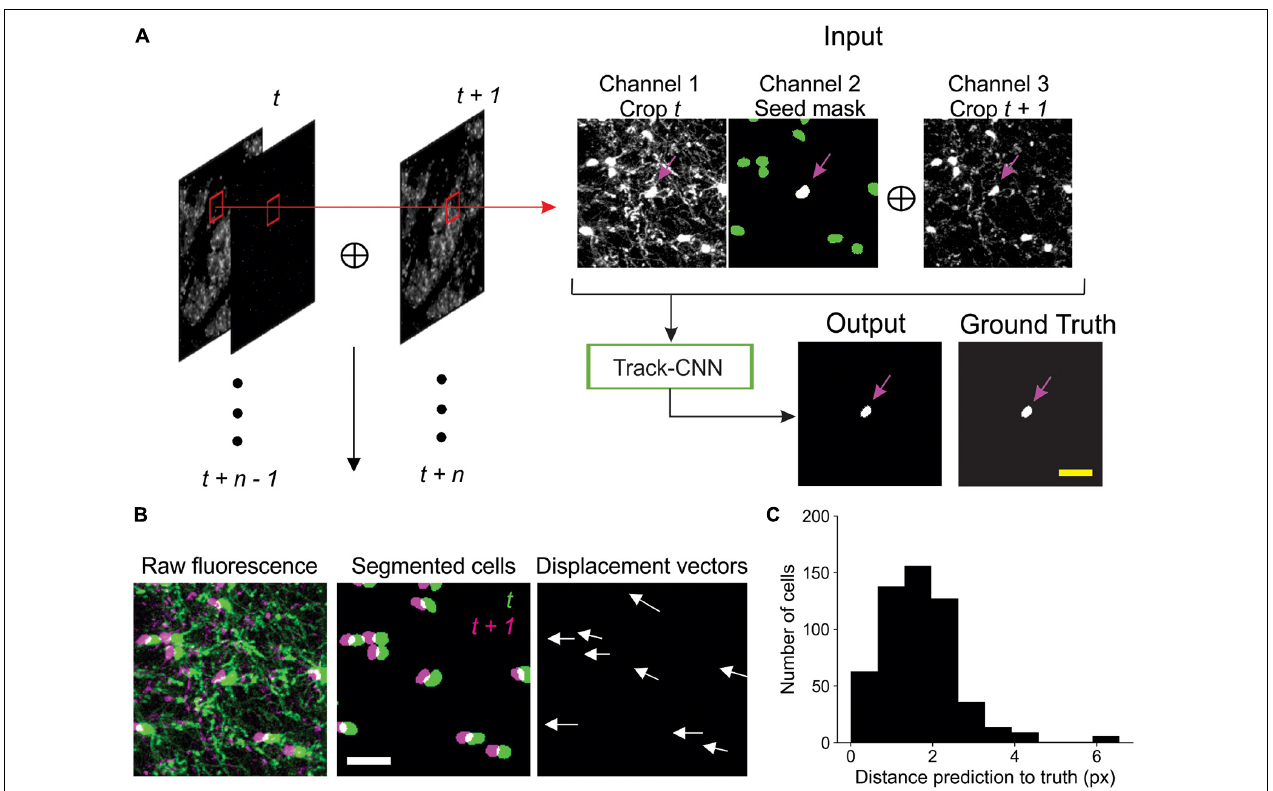
FIGURE 3 | Track-CNN processing steps. (A) Crops are taken from each pair of timepoints t and t + 1 centered around a cell denoted by magenta arrow on channel 1 . Channel 1 contains raw fluorescence from timepoint t . Channel 2 contains seed mask of cell of interest (magenta arrow). Adjacent segmented cells are set to a lower value (green). Channel 3 contains raw fluorescence from timepoint t + 1 . Cropped images are concatenated together to form input to network. The network output is a semantic segmentation indicating the location of the seed masked cell on timepoint t + 1 . This procedure is repeated for all cells on all consecutive timepoints. Scale bar: 30 µ m. (B) Example showing local coherence in how tracked cells in a local region shift between timepoint t (green) and t + 1 (magenta), allowing for predictive post-processing using displacement vectors of each tracked cell from timepoint t to t + 1 (white arrows). Scale bar: 30 µ m. (C) Distribution of distances from predicted to actual location of cell on timepoint t + 1 given any cell on timepoint t . The prediction is generated by taking the average displacement vector of five nearest neighbor tracks. Differences between predicted and actual location were typically within six